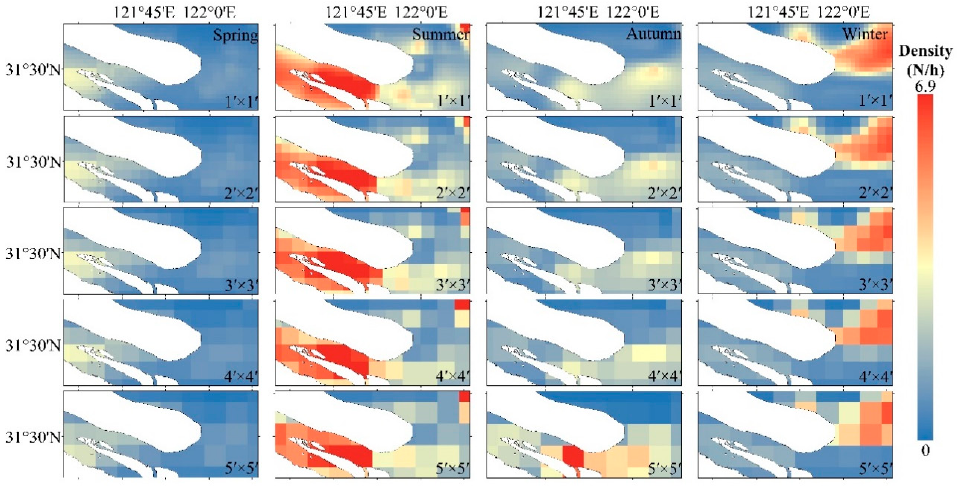
Figure 5. Spatial distribution of Coilia nasus predicted using interpolated environmental variables from different spatial resolutions in 2012 in the Changjiang River estuary.